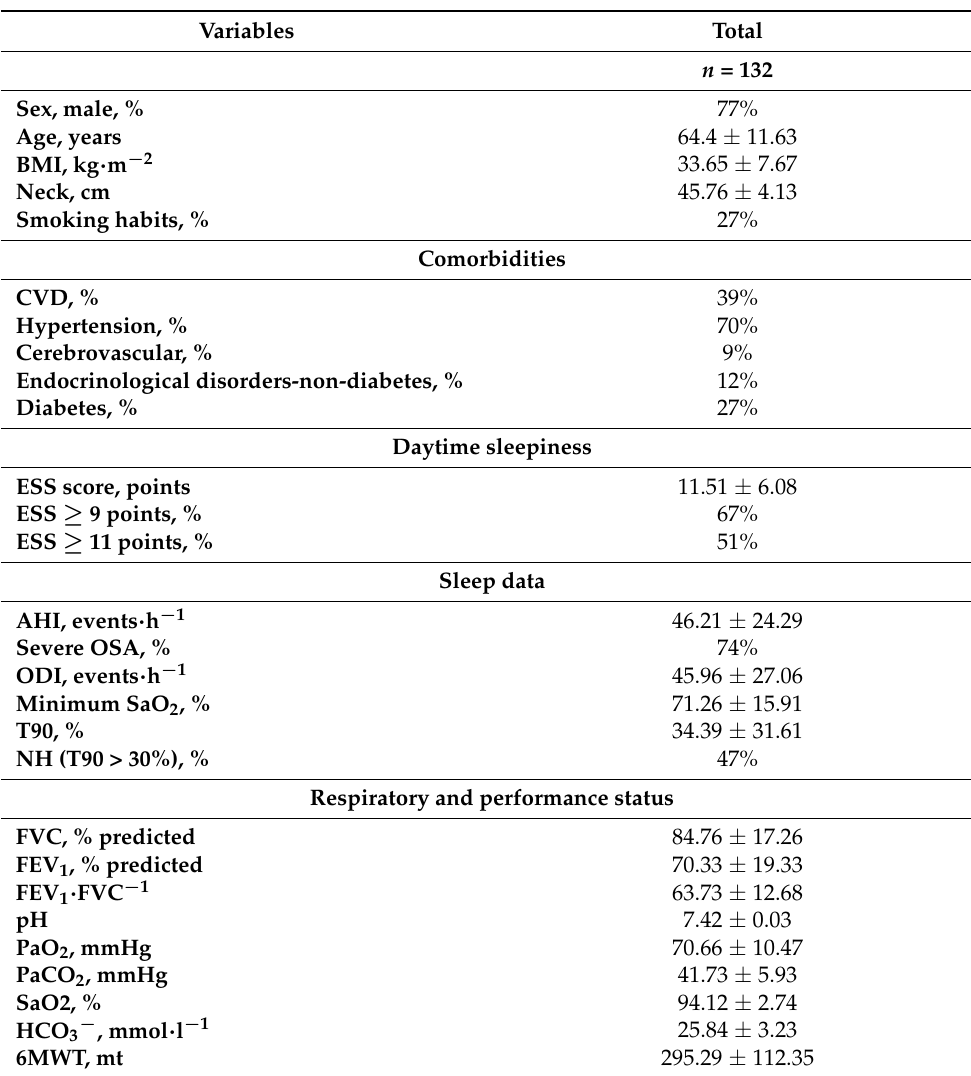
Table 1. General characteristics of